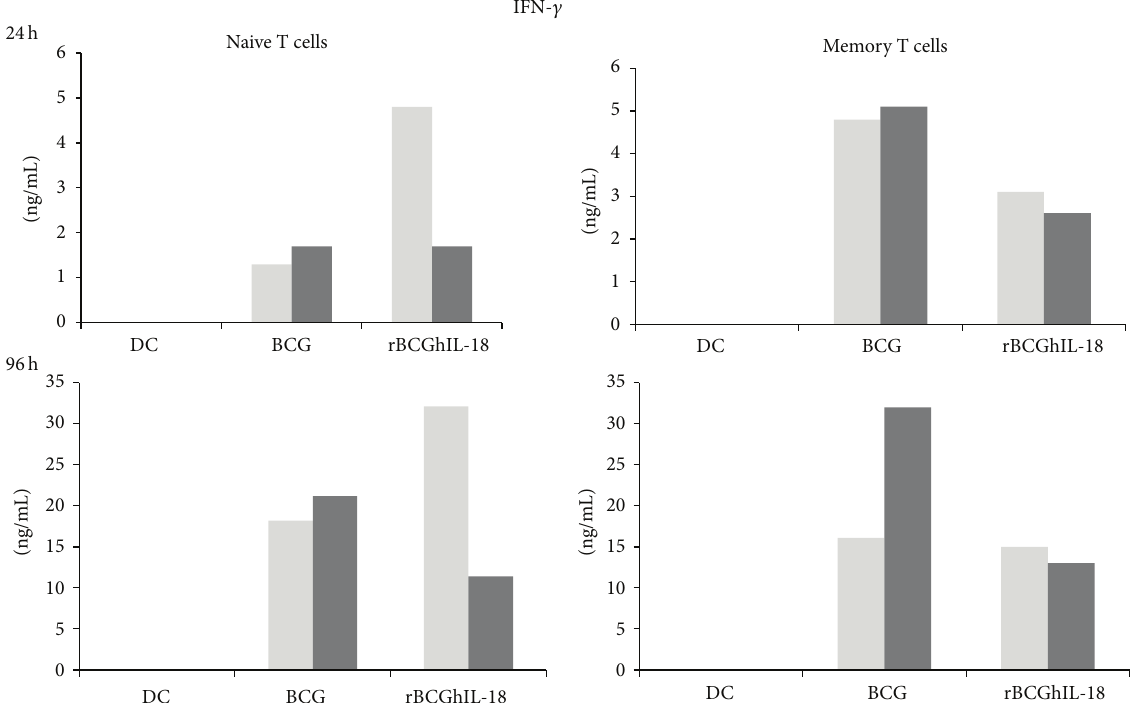
Figure 8: Secretion of IFN- 𝛾 by human naive and memory T cells following 24h and 96h coculture with BCG- (1: 1), rBCGIL-18- (1: 1) pulsed autologous MoDCs (ratio MoDCs/T cells, 1: 10) in the presence (black bars) of neutralizing human anti-IL-18 antibody or not (grey bars). The cytokine level in the cocultures was measured by ELISA. One representative experiment out of three independent ones is